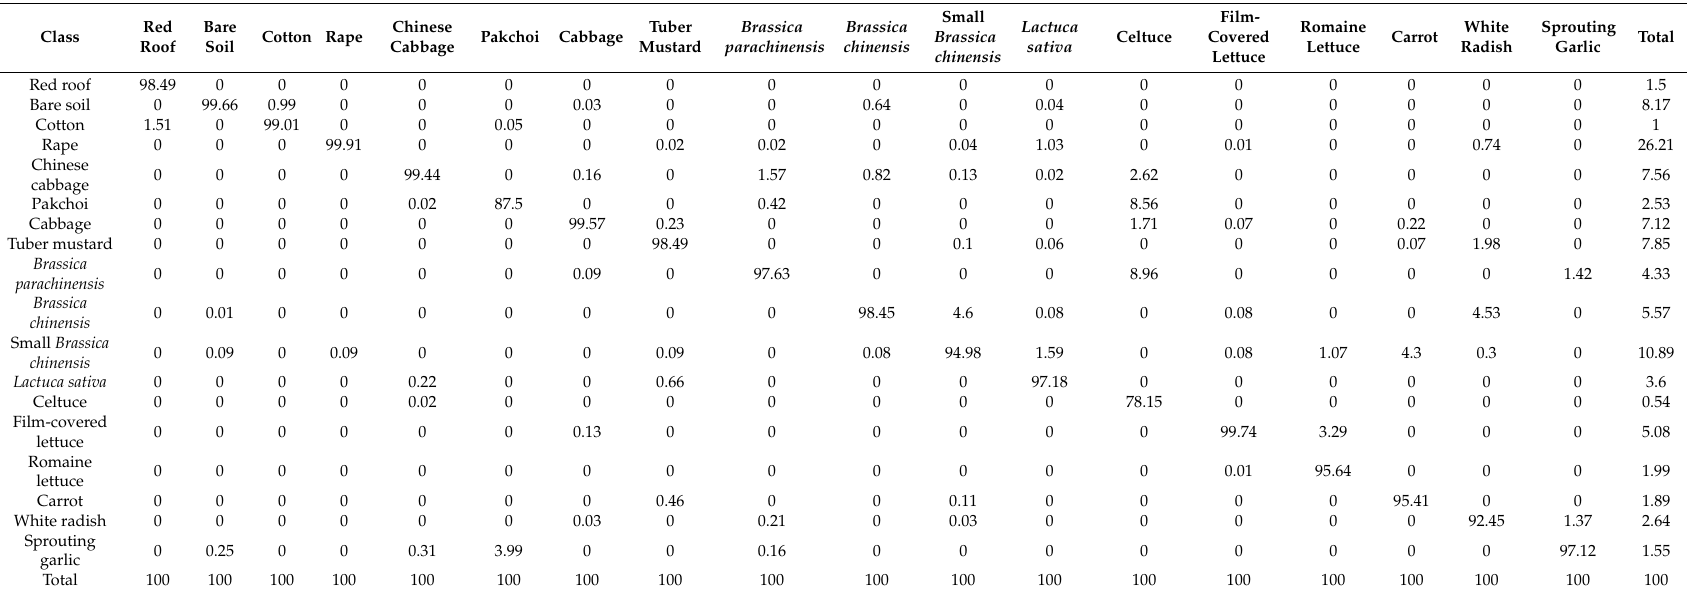
Table 4. The confusion matrix of SSF-CRF for the Honghu dataset